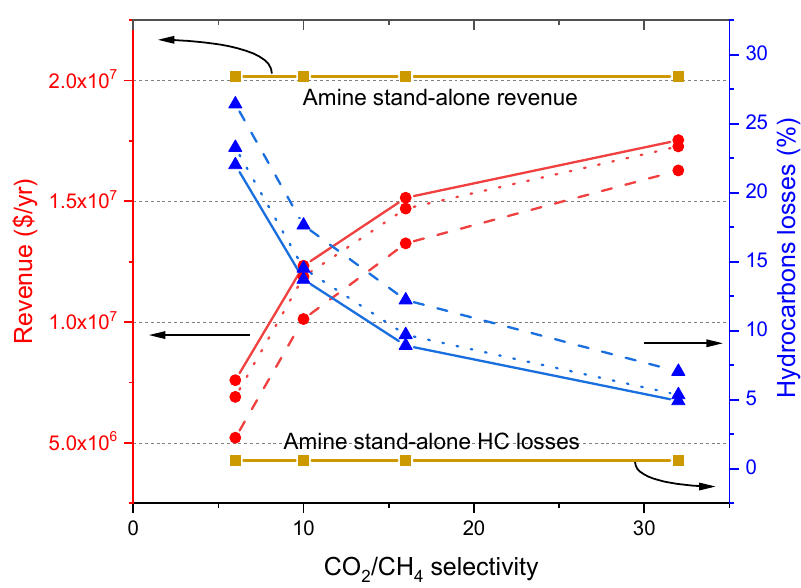
Figure 6. Effect of CO 2 /CH 4 selectivity on revenues (left axis) and hydrocarbon losses (right axis) of the hybrid process at pressure ratio values of 10 (dash lines), 20 (dot lines), and 30 (solid lines). The values are compared to the stand-alone amine process (horizontal dark yellow line). Red curves correspond to revenue and blue curves correspond to hydrocarbon losses. Membranes 2020 , 10 , x FOR PEER REVIEW